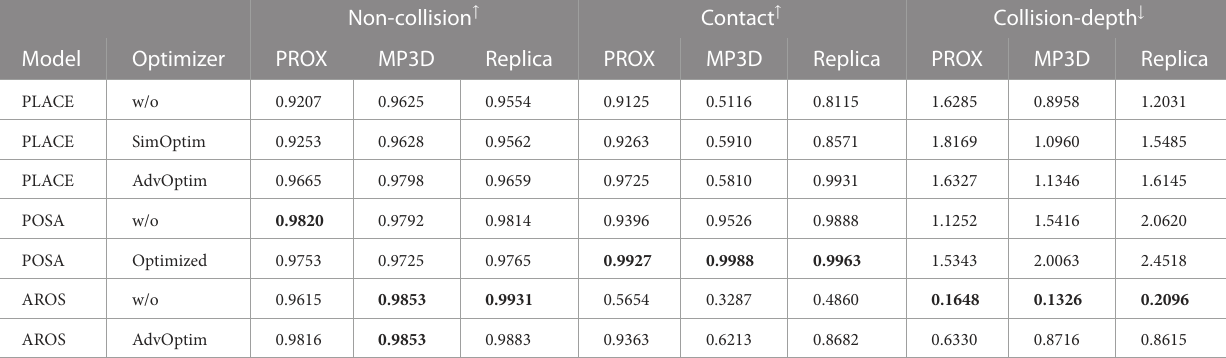
TABLE2 Physicalplausibility:Non-collision,contact,andcollision-depthscores( ↑ :benefit; ↓